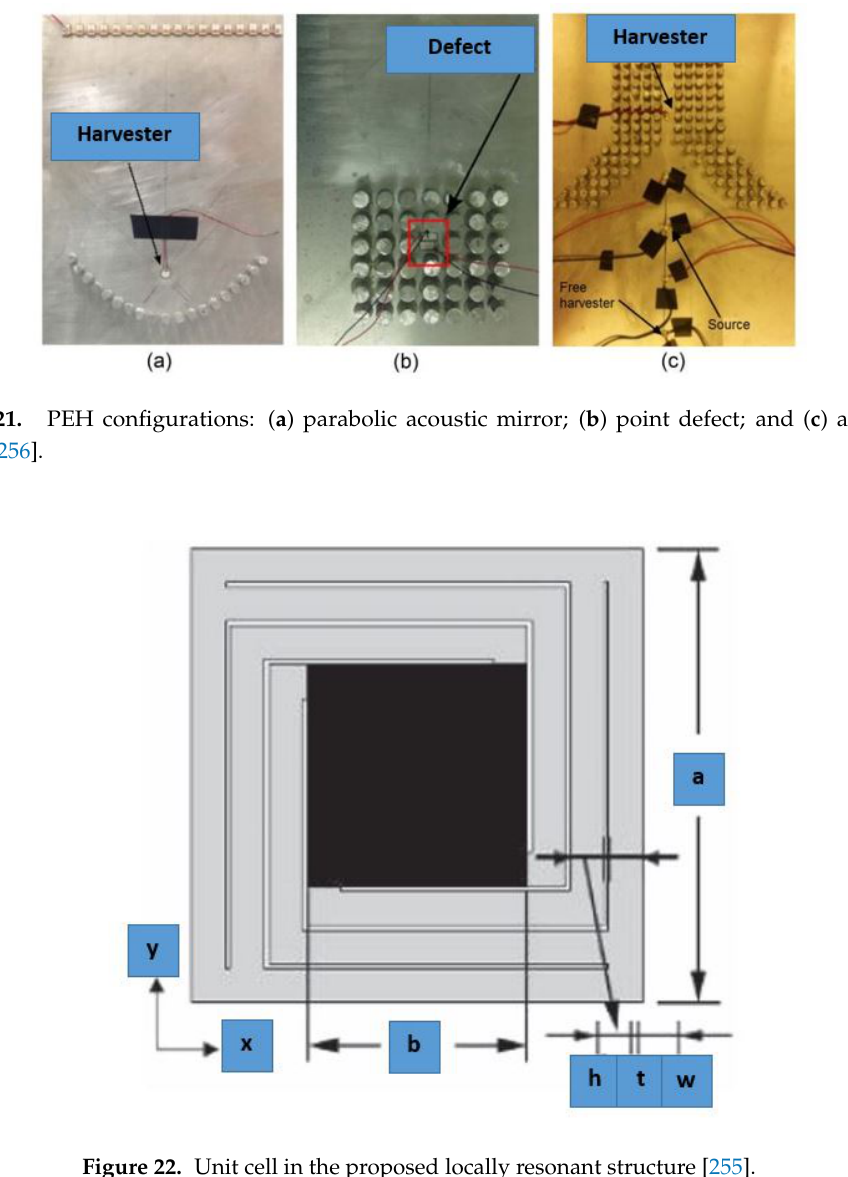
Figure 22. Unit cell in the proposed locally resonant structure